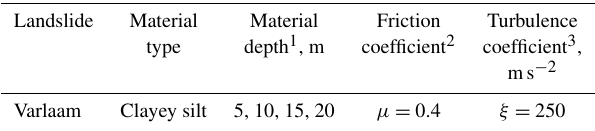
Table 2. Input parameters used in the runout